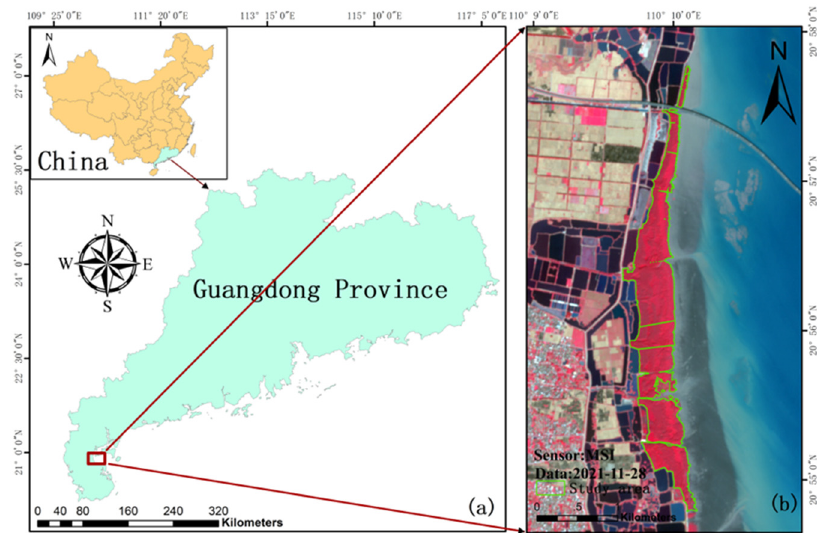
Figure 1. Location of the study area: ( a ) location of the mangrove forest in Fuchengtown of Leizhou City, Zhanjiang City, Guangdong Province (map taken from the standard map service website http://bzdt.ch.mnr.gov.cn (accessed on 15 December 2022), review number GS (2019)1822); ( b ) false color composite map of 8, 4, and 3 bands of Sentinel-2 satellite data in the study area.